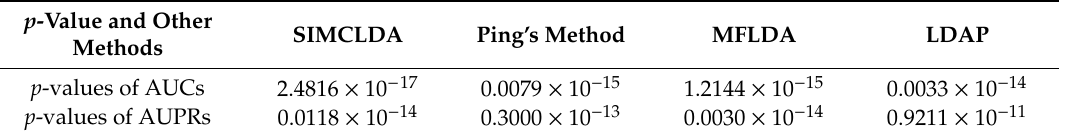
Table 3. Results of a paired Wilcoxon-test for LDAPred and four other contrast methods in terms of AUCs and AUPRs.